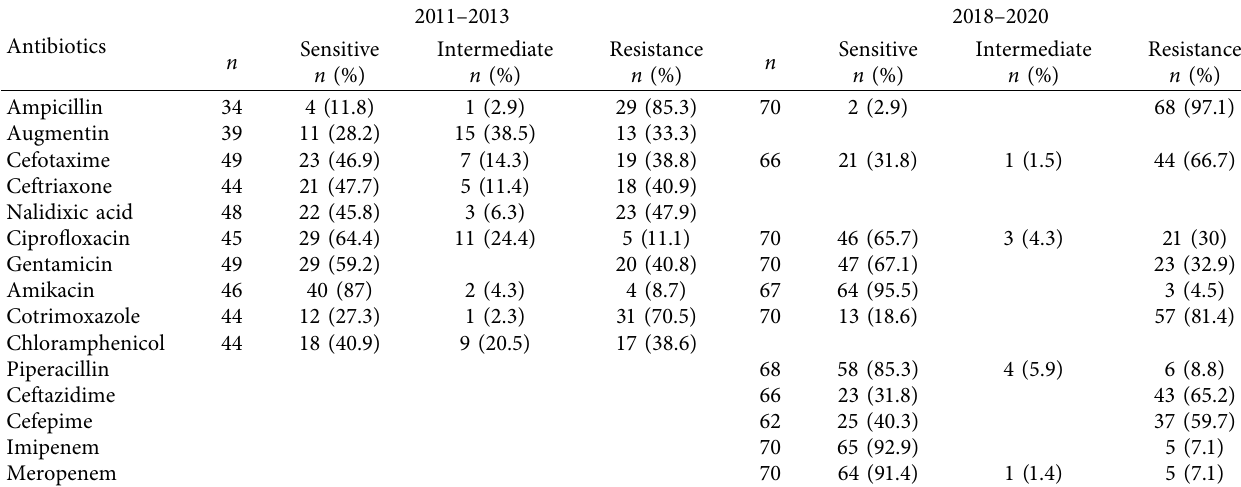
Table 3: Antibiotic sensitivity test results of E. coli isolates ( N �